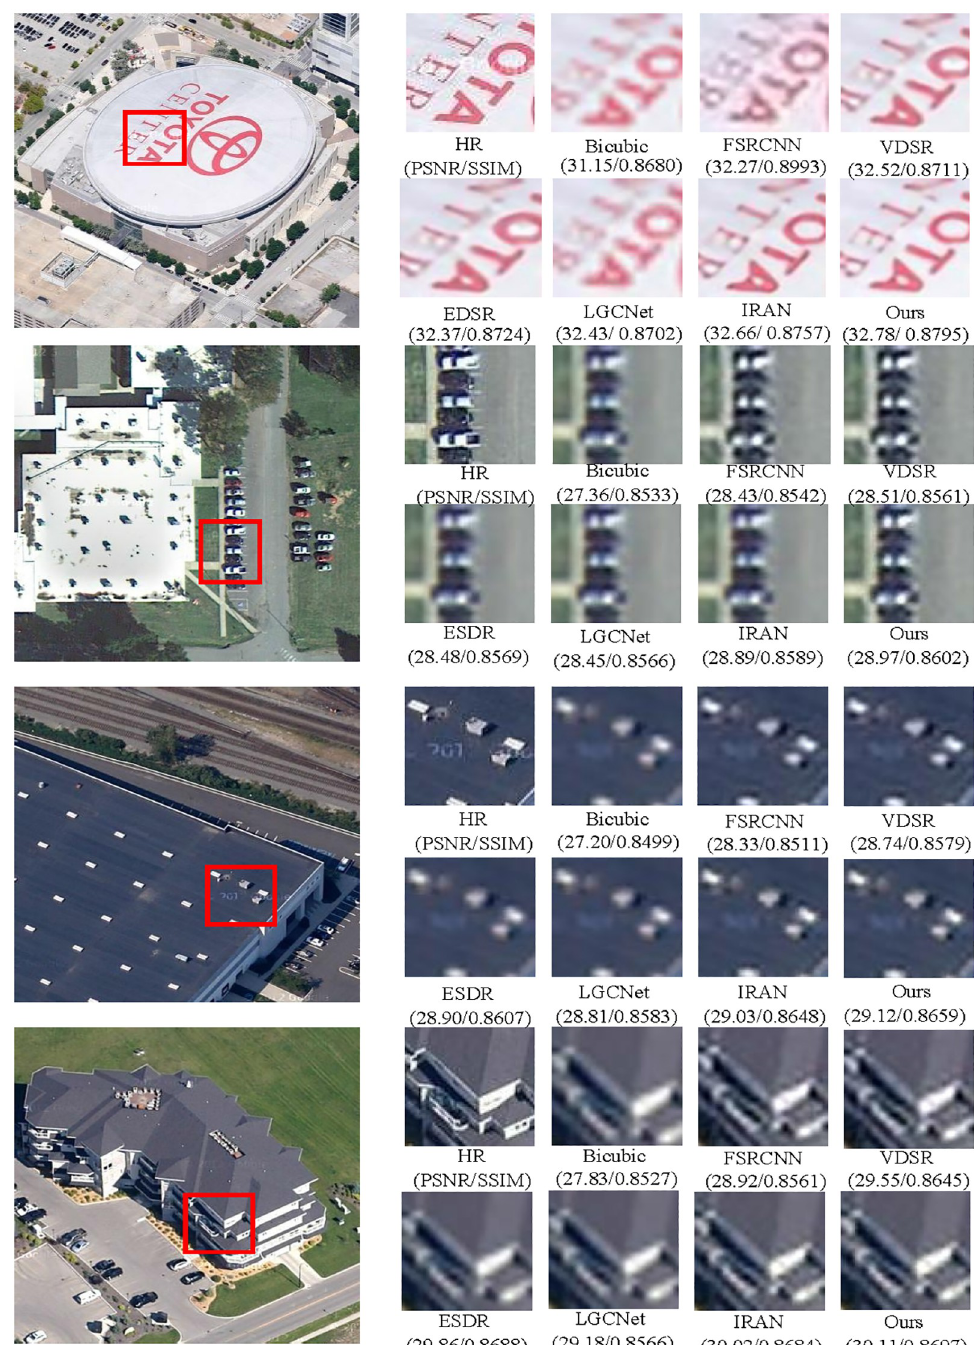
Fig 4. The visual comparison results magnified by an upscaling factor